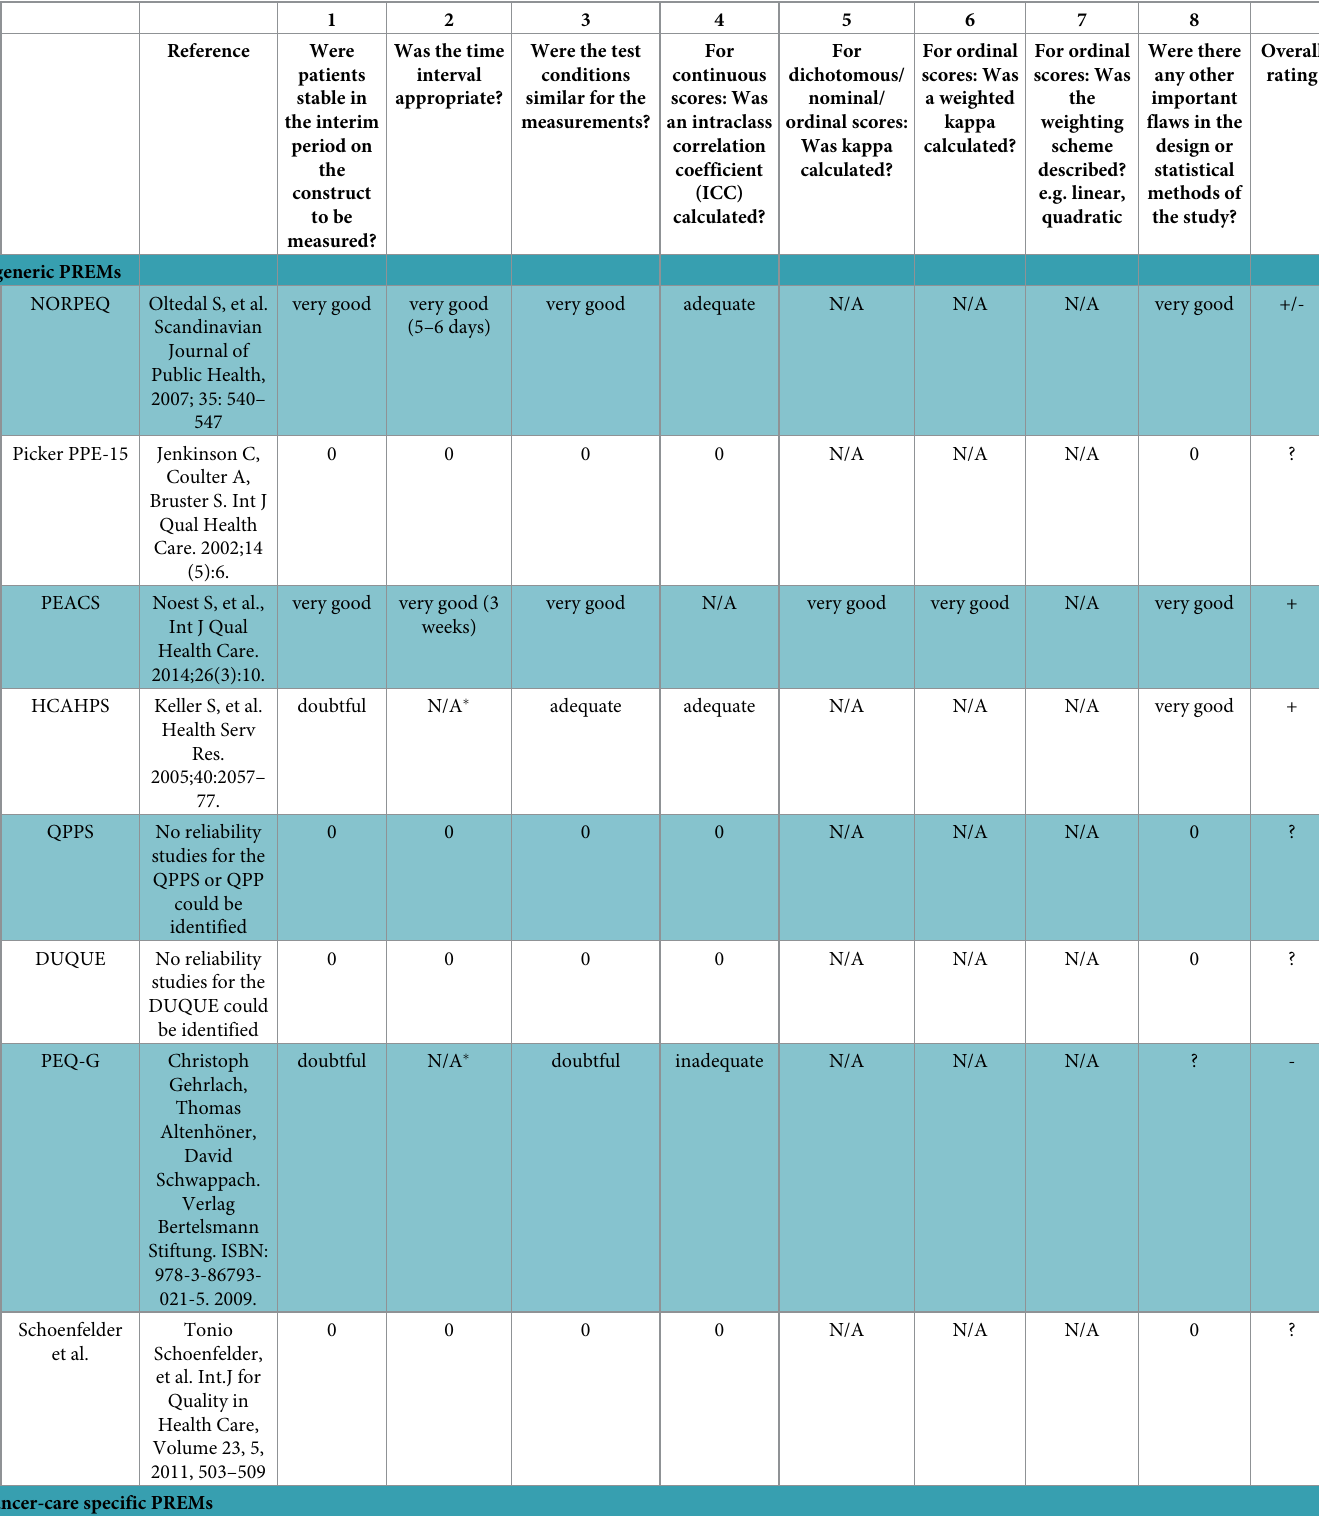
Table 8. Results of reliability analyses of German-language PREMs. Rating according to COSMIN